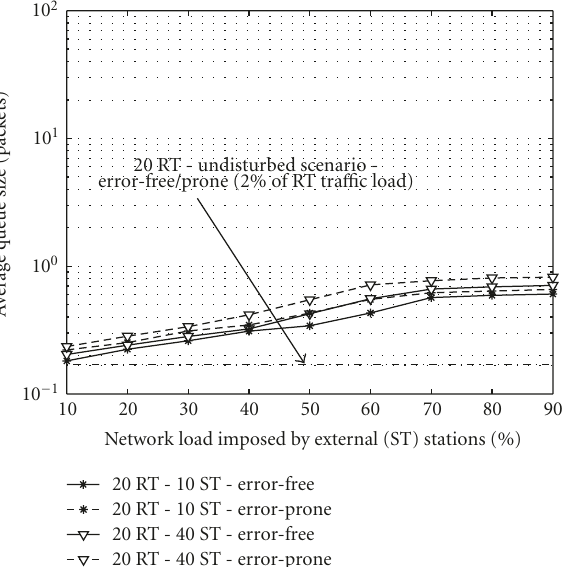
Figure 3: Average queue size (small and large pop.): error-free versus error-prone—MSP = 2 ms.